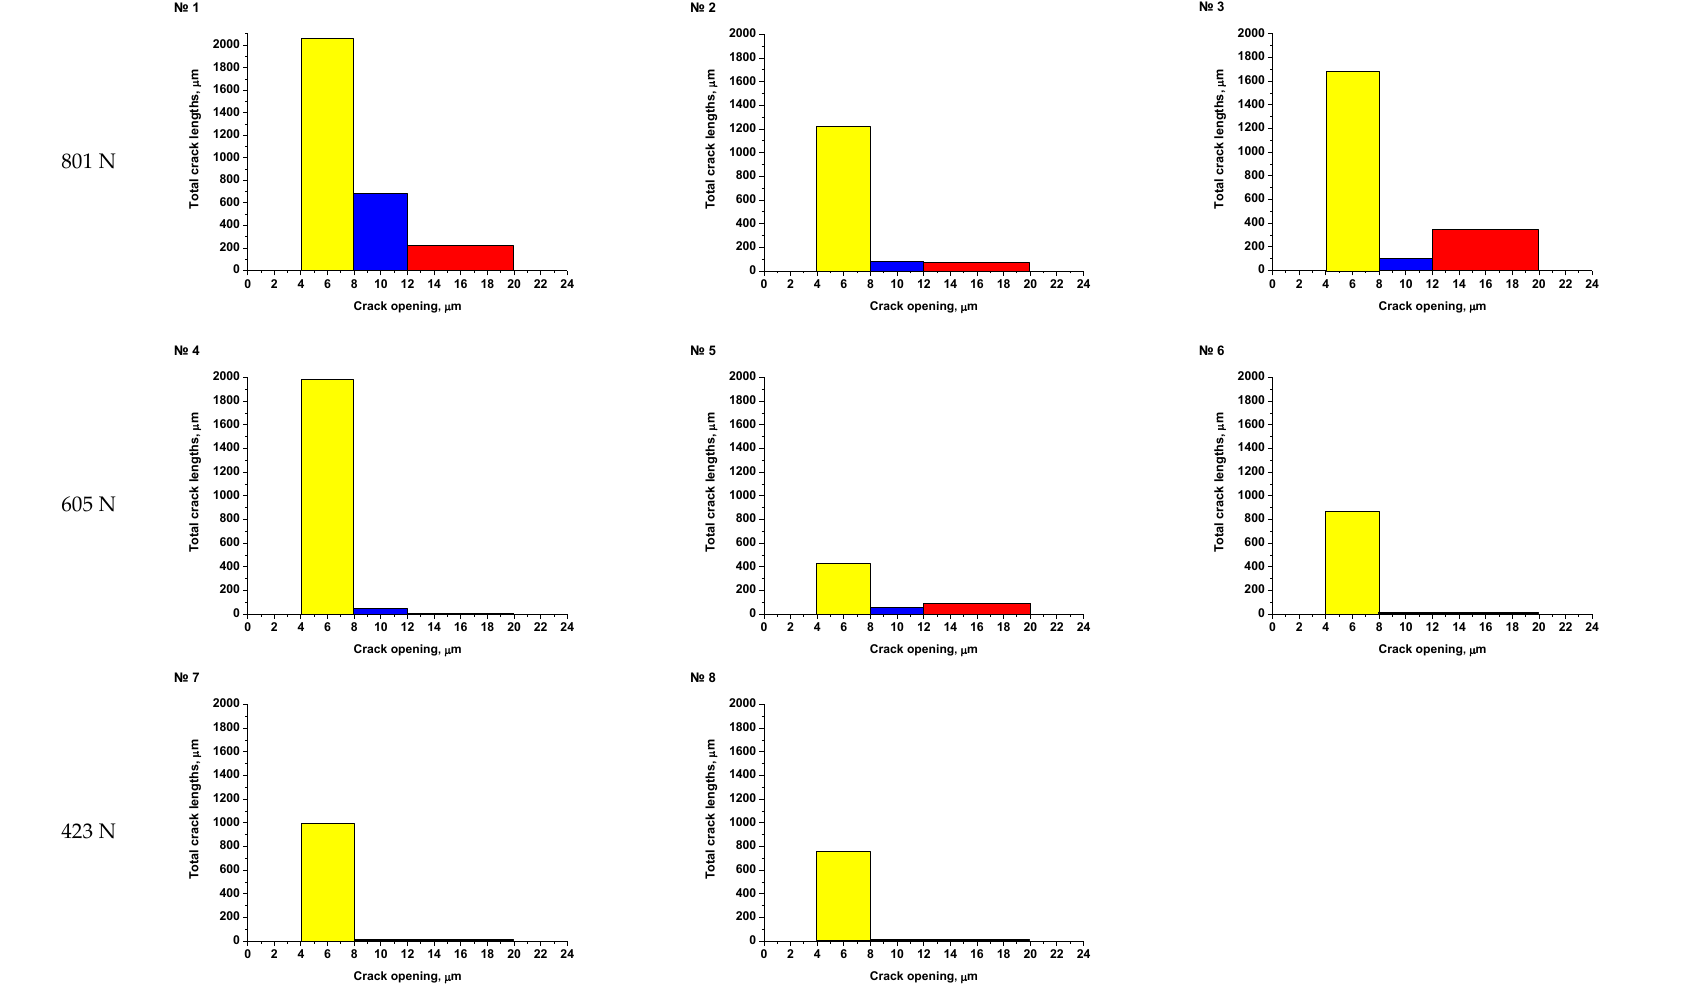
Figure 21. Total microcracks lengths with different microcrack opening values for specimens № 1–№ 8 irradiated at 390 °C after autoclave tests and additional loading.